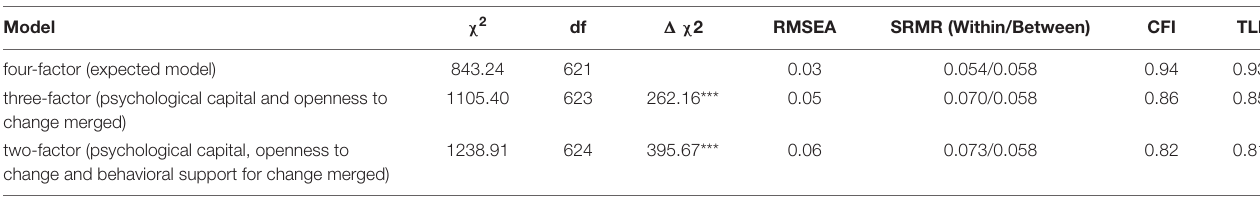
TABLE 1 | Alternative model test results for the study variables. Model four-factor (expected model)